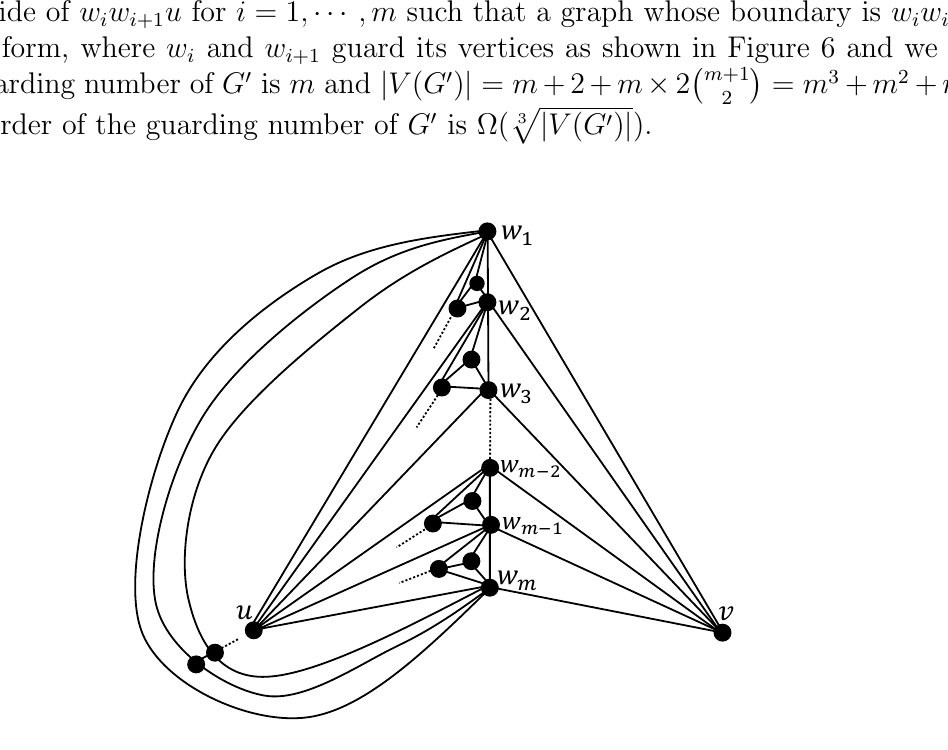
Figure 6: A triangulation G ′ on the sphere such that the order of guard( G ′ ) is Ω( 3